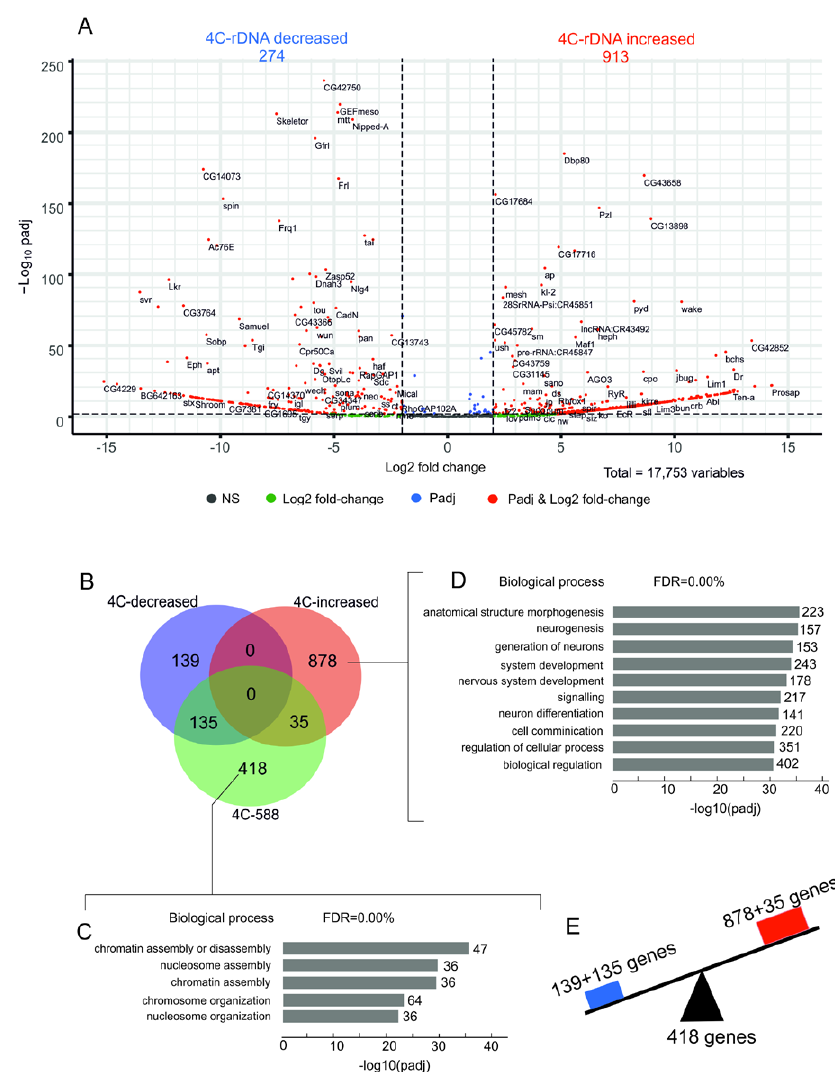
Figure 5. Analysis of changes in the contacts of genes with rDNA clusters after heat shock treatment. ( A ) The volcano plot presents the statistically significant log2-fold changes in contacts of genes with rDNA clusters determined in 4C-rDNA experiments. The list of 17,753 genes from the gene annotation for the dm6 / BDGP6.22 genome build was used. Of these, 274 genes demonstrated a decrease in the number of contacts, while 913 genes revealed an increase in the number of contacts. The list of the corresponding genes ranked by padj is shown in Table S5. ( B ) The Venn diagram shows the intersections of these two groups of genes with the list of selected 588 rDNA-contacting genes detected in untreated S2 cells. GO associations of 418 genes indicated in the Venn diagram are shown in Table S6. GO associations of 135 and 139 genes indicated in the Venn diagram are shown in Tables S7 and S8, respectively. ( C ) The top five GO terms associated with 418 rDNA-contacting genes that retained their contacts with rDNA after the treatment correspond to genes that are involved in chromatin assembly. The values to the right of the bars indicate the number of corresponding genes. ( D ) The top ten GO terms associated with 878 rDNA-contacting genes that increased their contacts with rDNA after heat shock treatment and are associated with morphogenesis and development. The values to the right of the bars indicate the number of corresponding genes. The list of these genes is shown in Table S9. ( E ) The scheme illustrates that heat shock treatment induces an alteration of contacts between nucleoli and genes controlling morphogenesis (increase or